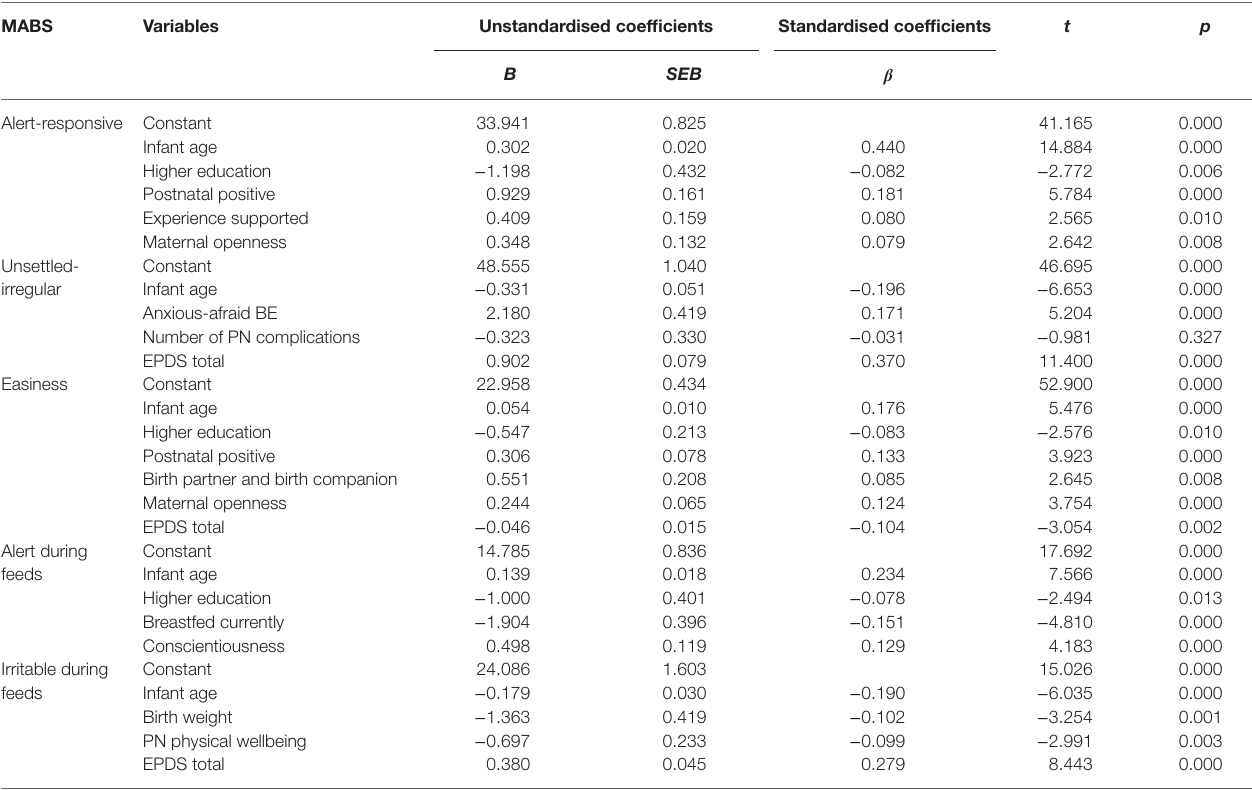
TABLE 10 | Predictors of infant behaviour (0–6